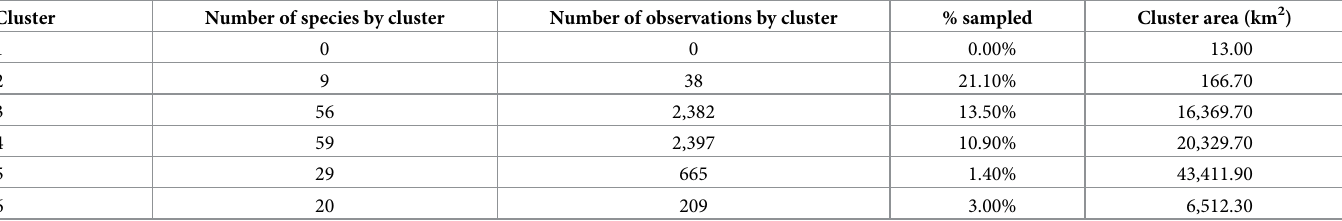
Table 1. List of all six climatic clusters that group 20% of the explained variance of PC1 and PC2 of the principal component analysis (PCA). The table shows the cluster denomination; the number of species present in each cluster, the number of observations detected in each cluster, the sampled percentage of each cluster and the total area of each cluster.